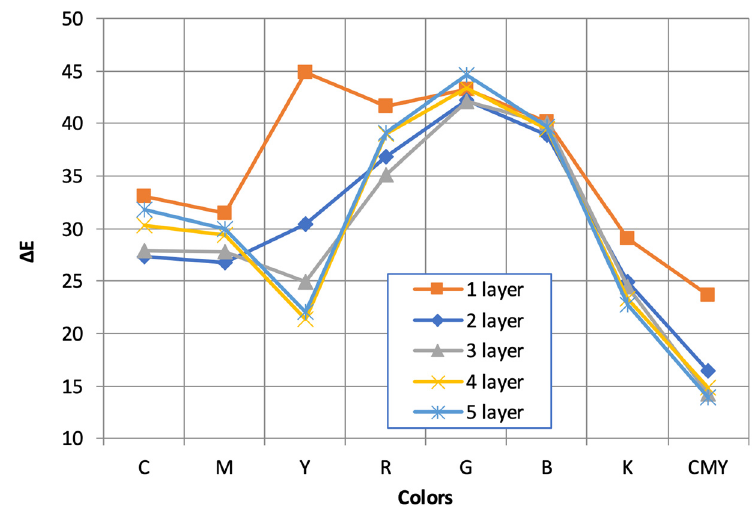
Figure 6. Different colors changes of Δ E value depending on dye layers when printing in 4 passes.